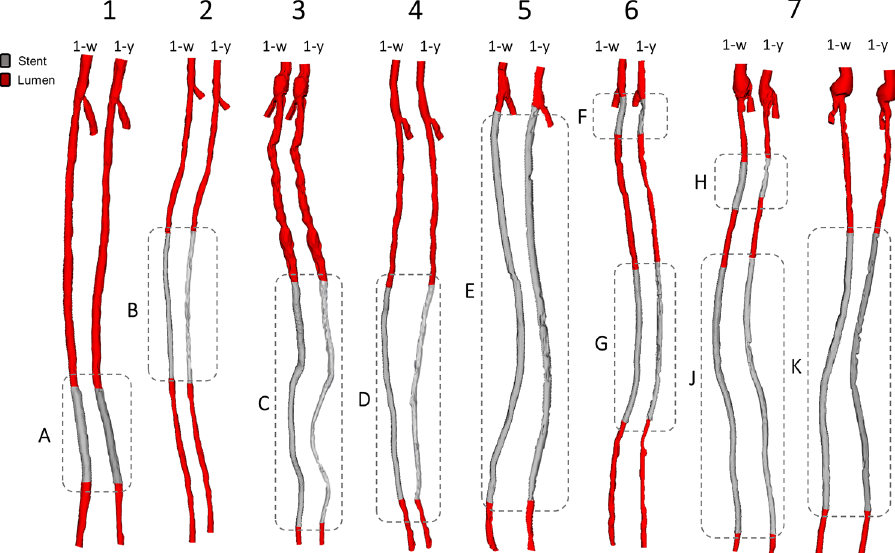
Figure 2. Three-dimensional reconstruction of the stented superficial femoral arteries derived from patients’ computed tomography images. For each patient, the vessel models at 1-week (1W) (i.e. baseline) and 1-year (1Y) follow-up are shown. The common femoral artery bifurcation is included in all vessel reconstructions. The lesion name is indicated besides each stented